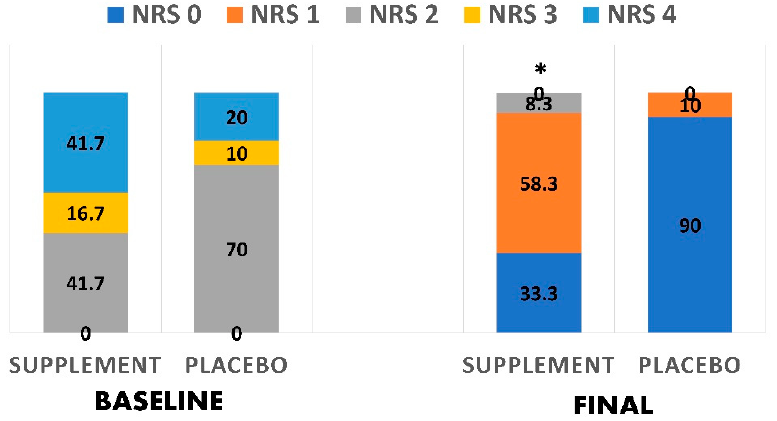
Figure 3. Changes in the nutritional status based on NRS2002 before and after interventions in both groups. * indicates a significant difference ( p < 0.05 ).